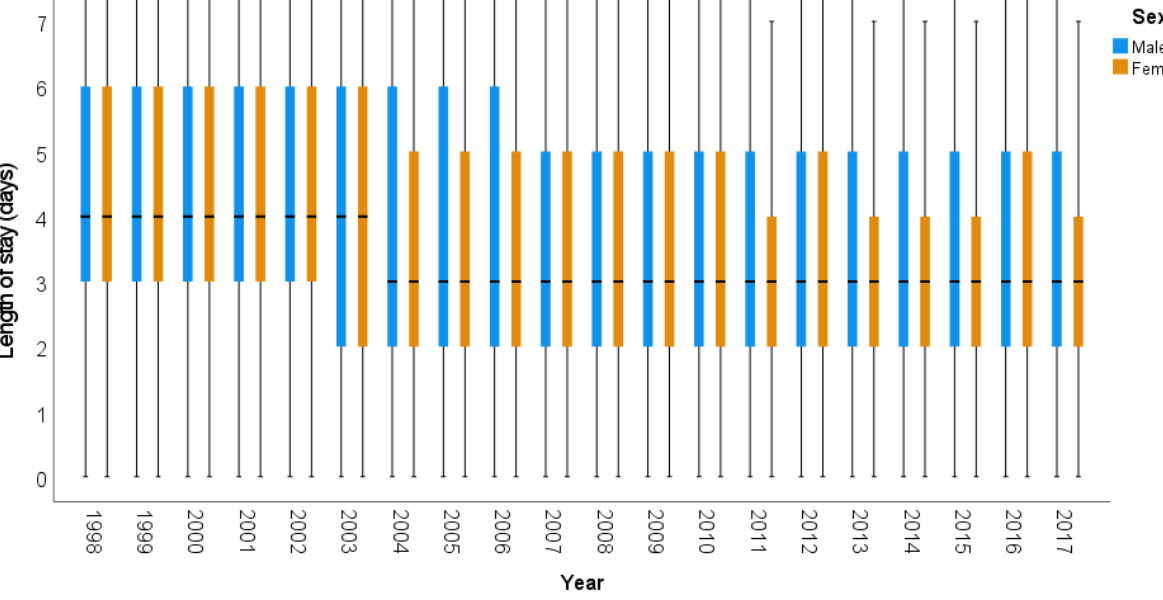
Figure 3. Box diagram for length of stay during admission for acute appendicitis, by year and gender.